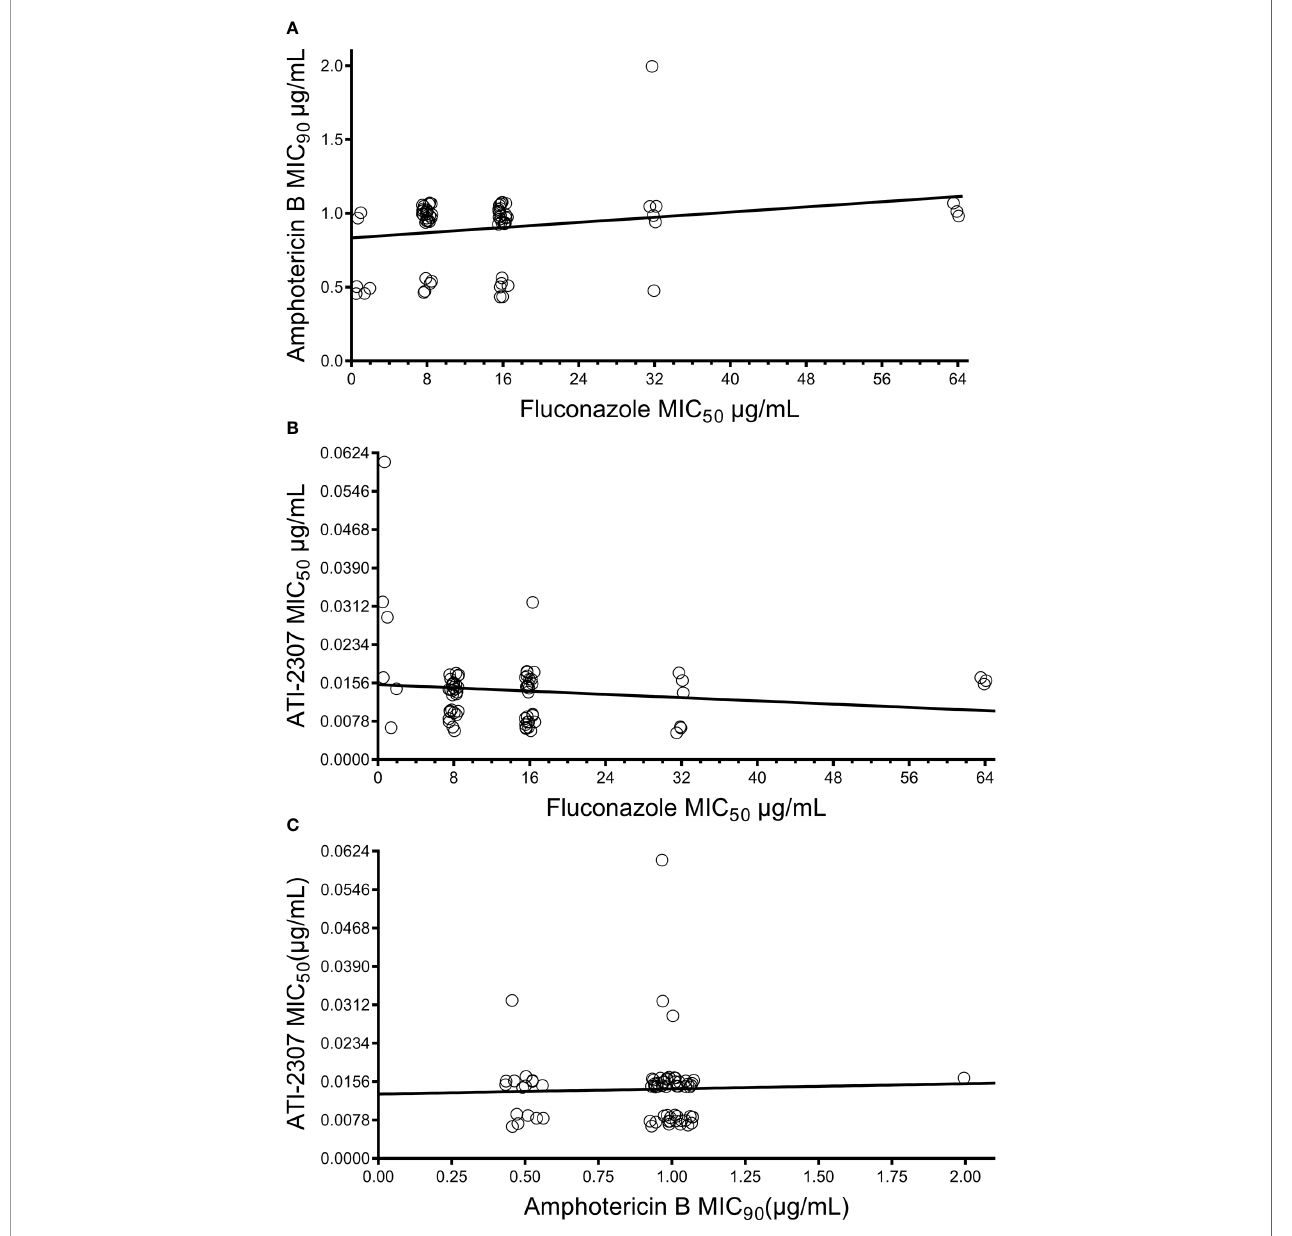
FIGURE 1 | Correlation between fl uconazole IC 50 , amphotericin B IC 90 , and ATI-2307 IC 50 values for Cryptococcus neoformans clinical isolates. No correlation was observed between (A) fl uconazole and amphotericin B susceptibilities (rho = 0.2049, P = 0.21), (B) fl uconazole and ATI-2307 susceptibilities (rho = -0.1690, P = 0.1650), or (C) amphotericin B and ATI-2307 susceptibilities (rho = 0.0125, P =